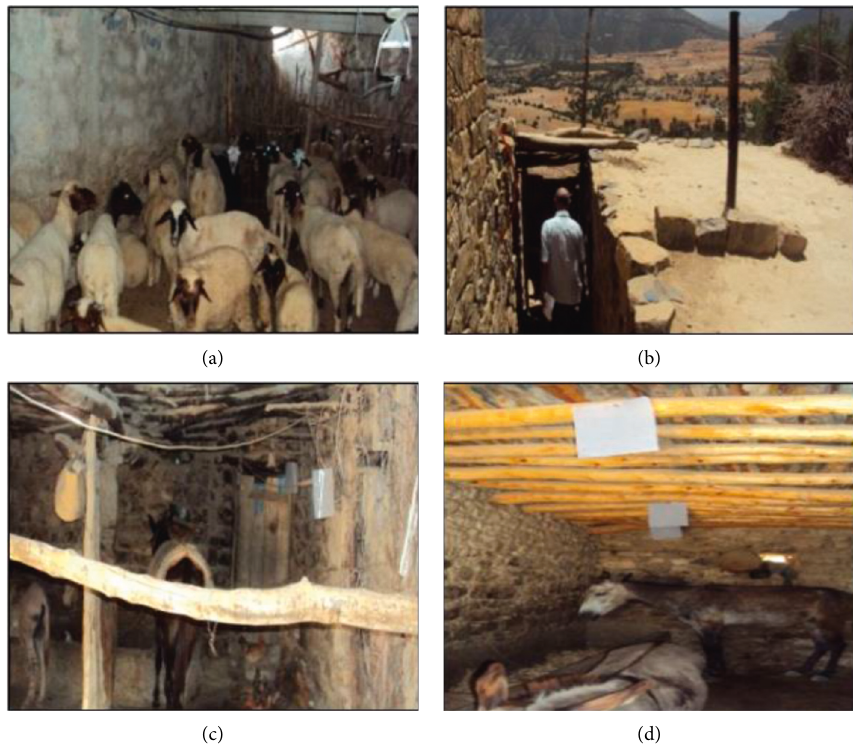
Figure 1: Different biotopes in the study area: (a) sheep pen, (b) the winery, (c) stable, (d) stable henhouse.